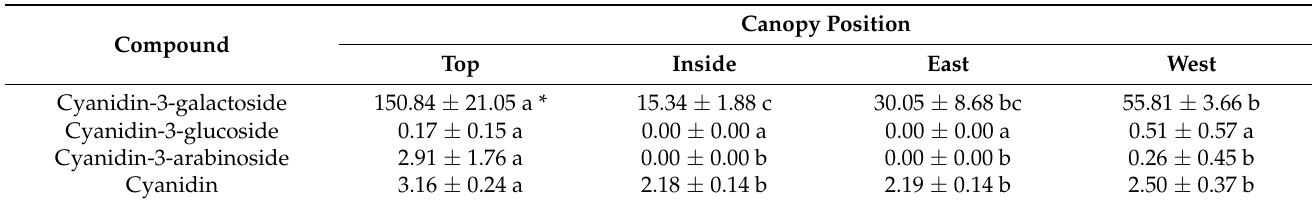
Table 7. Effect of canopy position on anthocyanin synthesis in apple fruits, mg g − 1 DW,